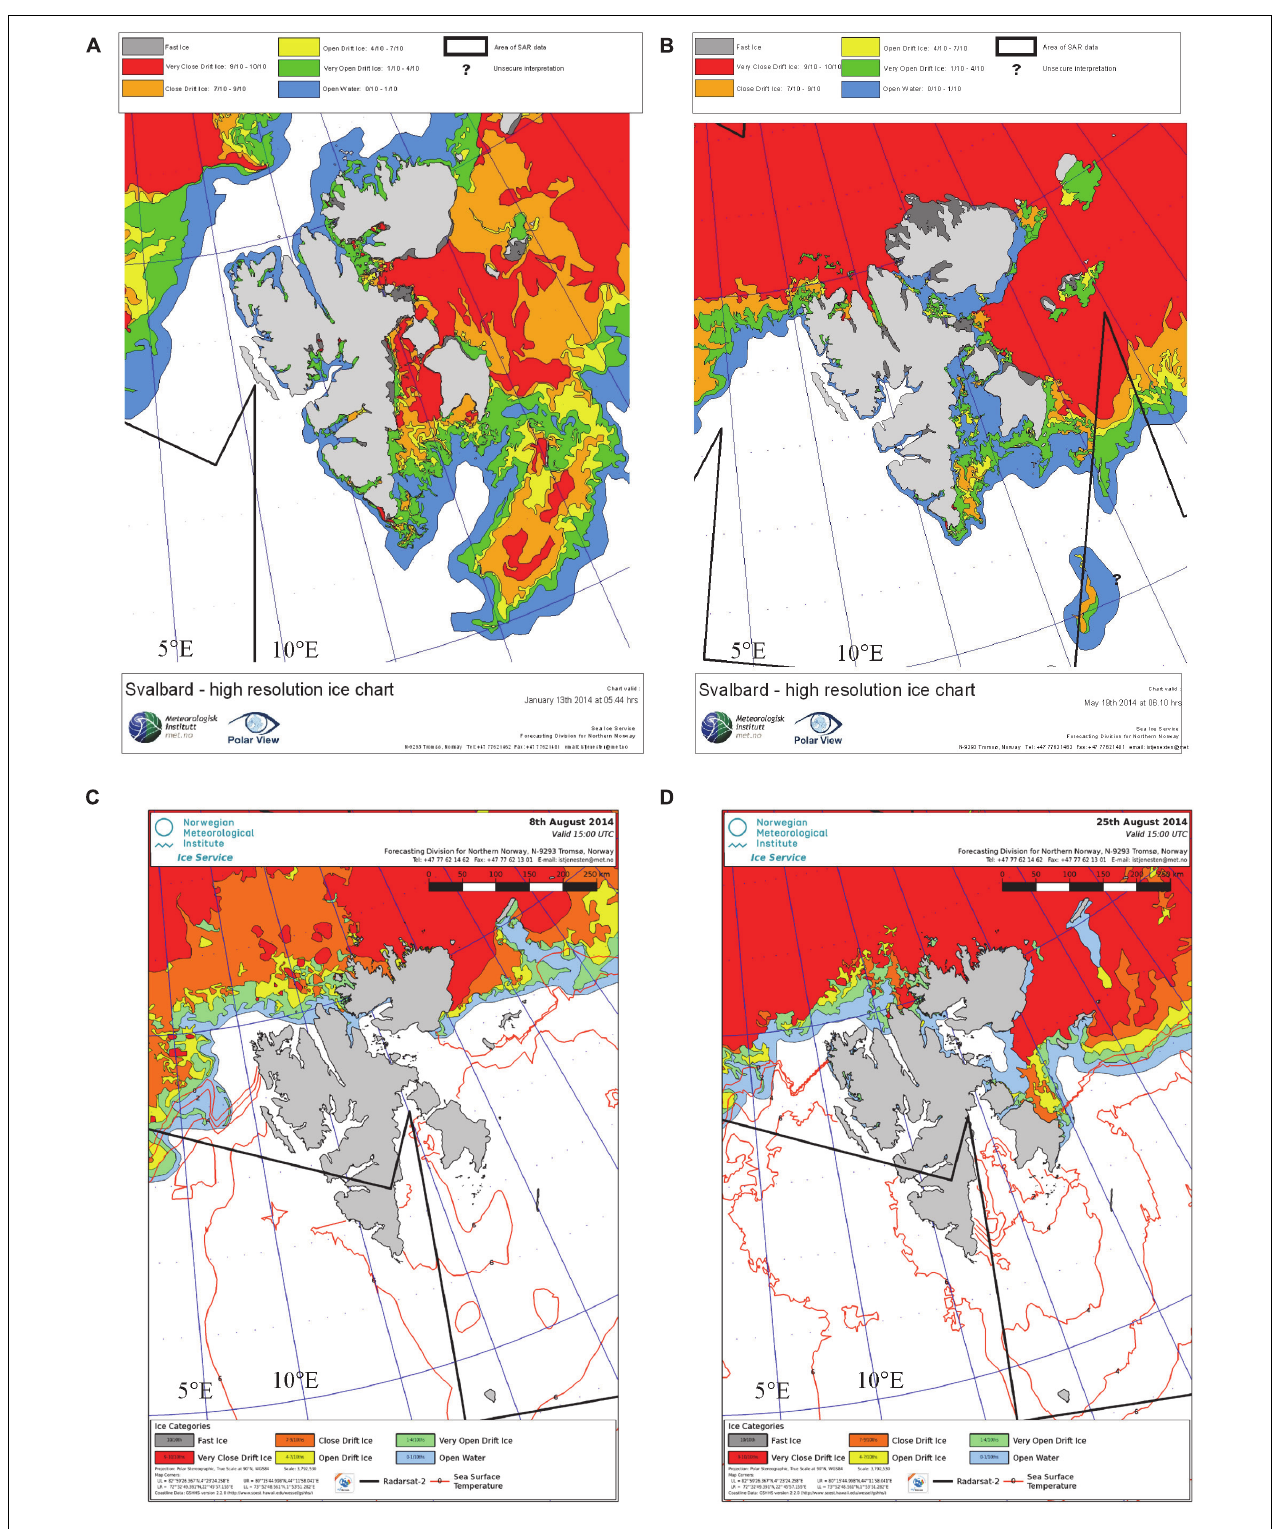
FIGURE 2 | Sea ice cover around Svalbard for selected dates during the four cruises: (A) 13th of January, (B) 19th of May, (C) 8th of August, and (D) 25th of August in 2014. Data is obtained from the Ice Service of the Norwegian Meteorological Institute (MET, http://polarview.met.no/) and use their ice chart color scheme for very open drift ice (1–4/10ths), open drift ice (4–7/10ths), close drift ice (7–10/10ths), and fast ice (10/10ths).